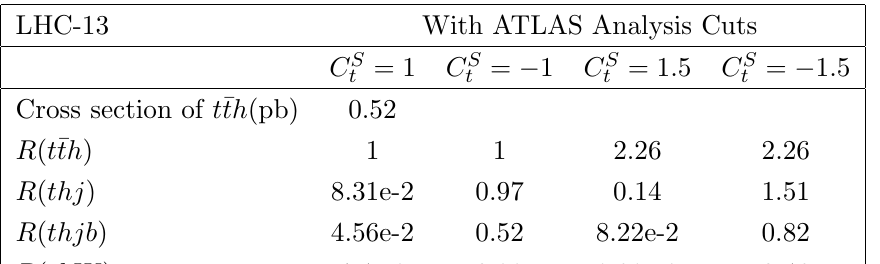
= (cid:6) 1 ; (cid:6) 1 : t